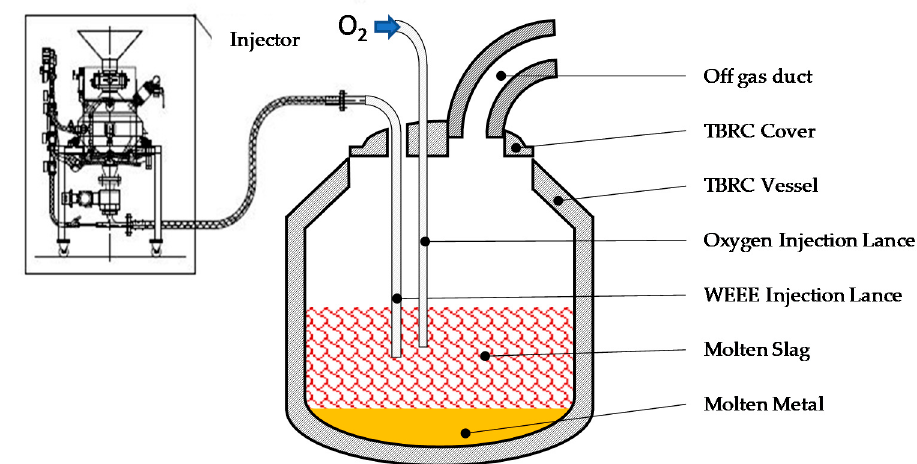
Figure 2. Schematic process of waste of electrical and electronic equipment (WEEE) powder injection into the slag phase.